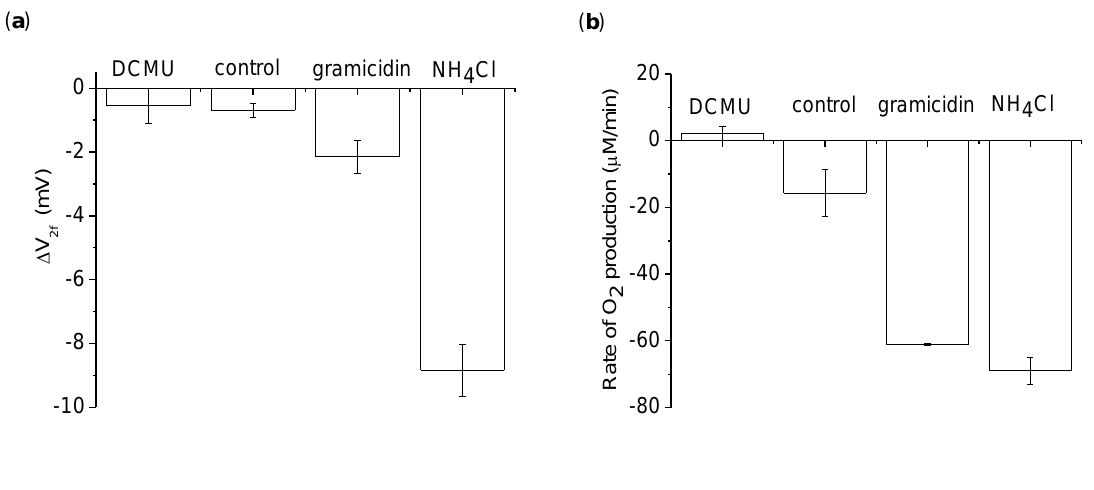
Figure 5. The 2nd harmonic response using 100 µM methyl viologen (MV) + 1 mM sodium azide as an electron acceptor. Measurements are of a 5 mL thylakoid suspension with 0.2 mg/mL chlorophyll. Additional conditions are given in different columns: 20 µM 1-dimethylurea (DCMU), 2 mM NH Cl, and 21.2 µM gramicidin. (a)  V measured with 4 2f a 3,072 Hz, 8 V sinusoid driving voltage. (b) The average O production rate during pp 2 the 2 min light application. This data was measured simultaneously with  V . The 2f background O absorption from the atmosphere was corrected for in this data by measuring 2 the rate of O increase of the buffer in the dark for 1 min before and after the light 2 exposure. The background O absorption was taken to be the average of the two dark 2 measurements. Each measurement was done 3 times, with the average and standard deviation shown. The one exception was in the O data of gramicidin, where one 2 measurement failed due to operator error and was removed from the